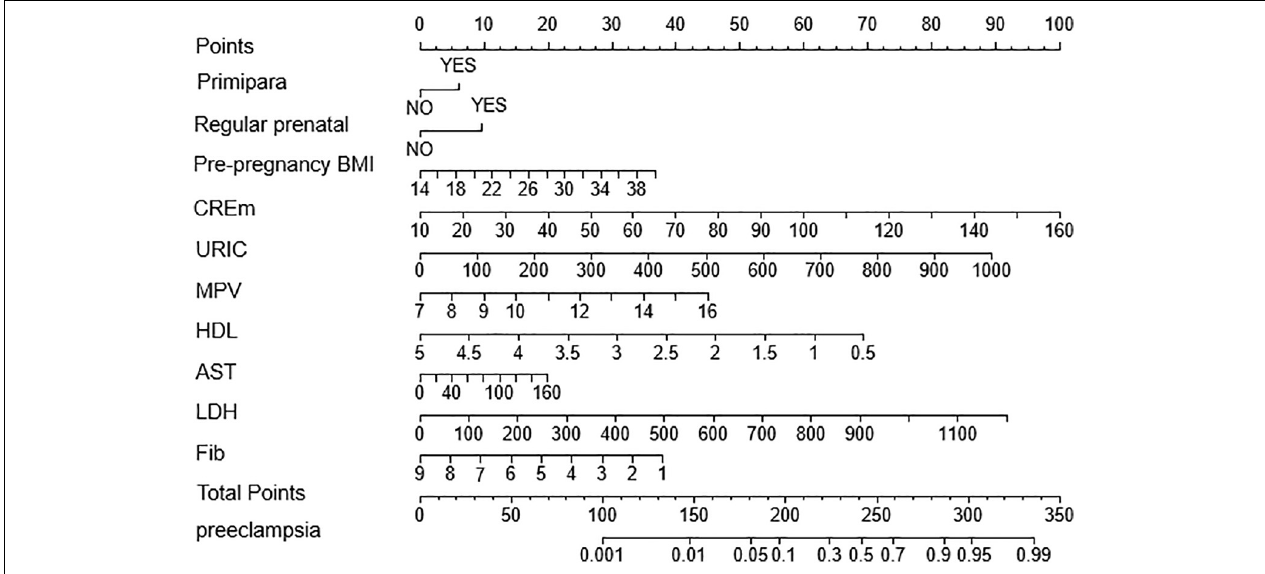
FIGURE 4 | Nomogram for predicting the risk of preeclampsia in twin pregnancies.